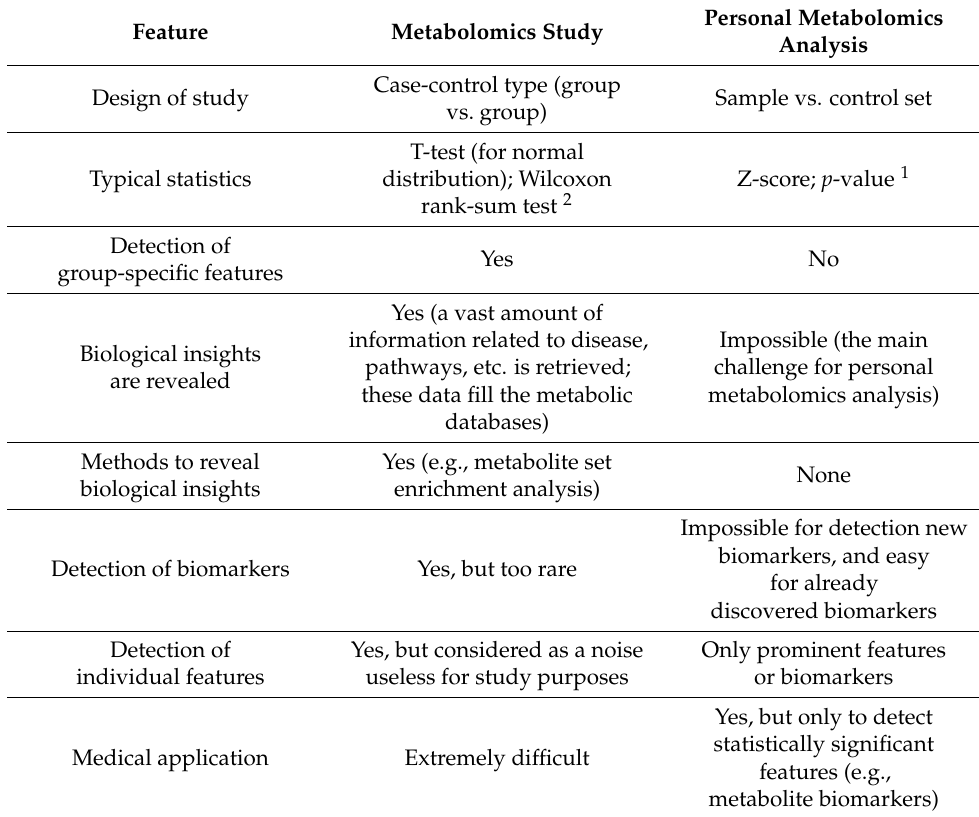
Table 2. Comparison of data processing in metabolomics case–control studies and personal metabolomics